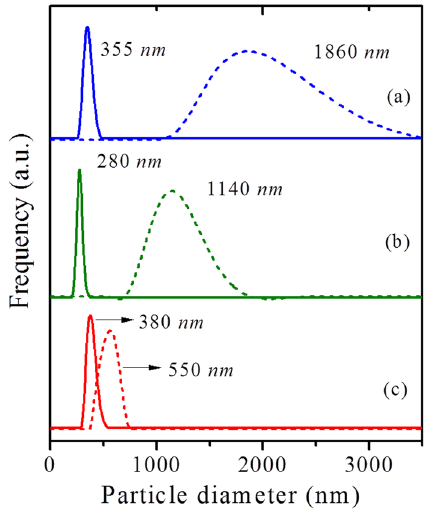
Figure 9. DLS particle size distribution profiles (hierarchical - solid lines; bulk - dotted lines): ( a ) ZH-Y and Z-Y; ( b ) ZH-X and Z-X; ( c ) ZH-A and Z-A.